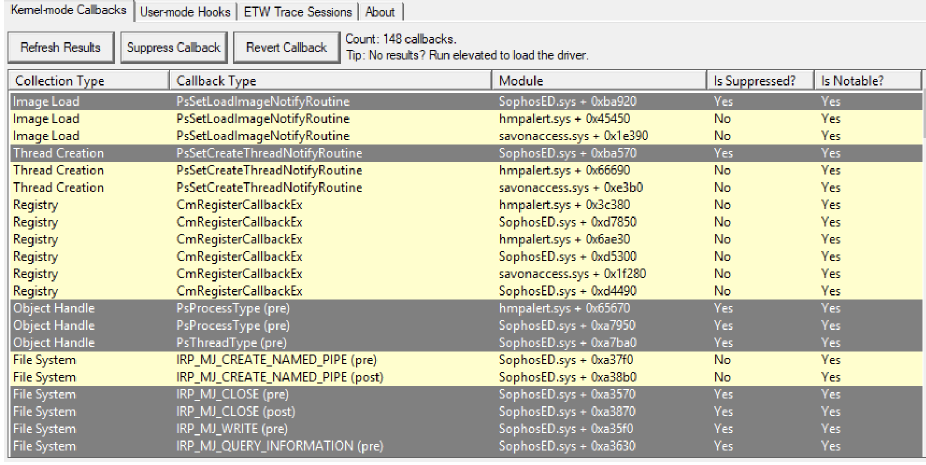
Figure 36. Deleting Sophos’ callbacks via Telemetry Sourcerer’s